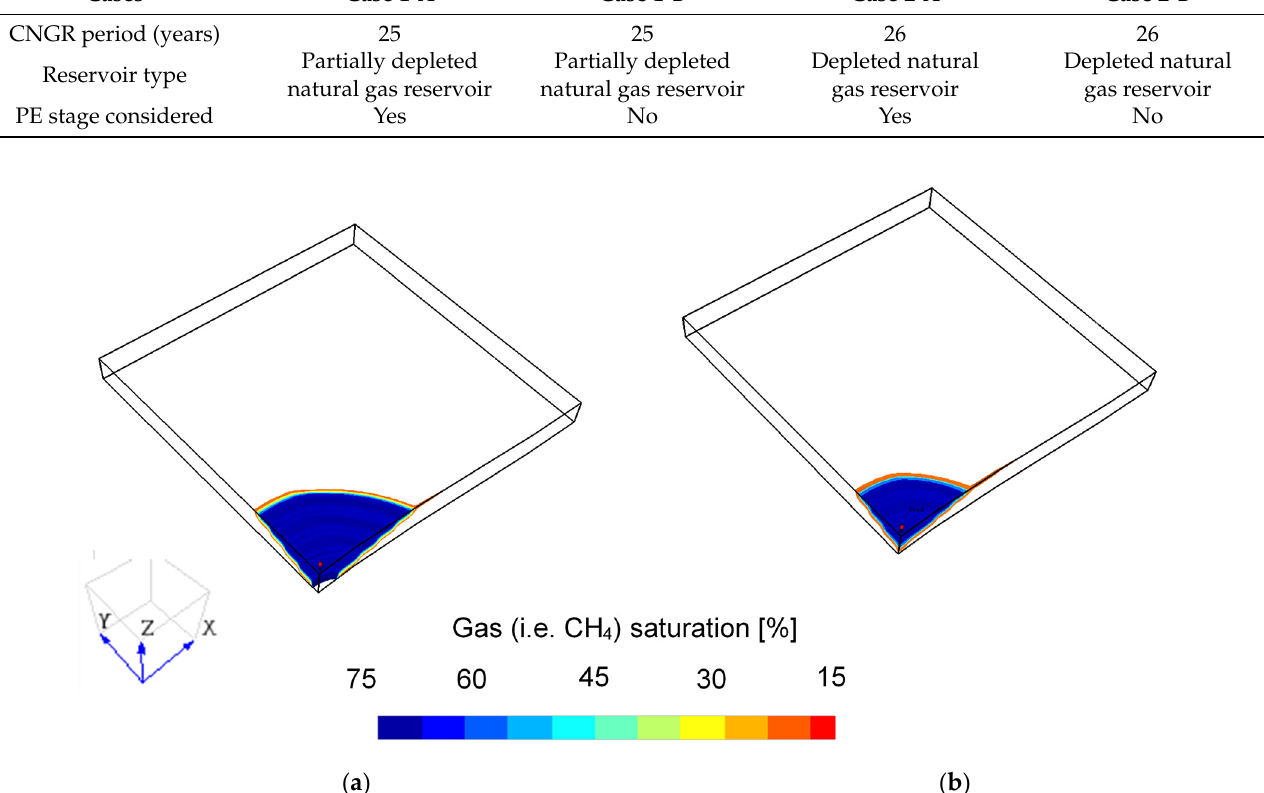
Figure 1. Quarter model showing the gas (i.e., CH 4 ) saturation in the reservoir pore space after the CNGR stage for the partially depleted ( a ) and depleted ( b ) natural gas reservoir model. Note that the part of the model with gas (i.e., CH 4 ) saturation less than 15% (i.e., high brine saturation) has been blanked. Table 2. Description of the four cases used to show the effects of residual CH 4 content and CO 2 -plume establishment stage on the performance metrics.